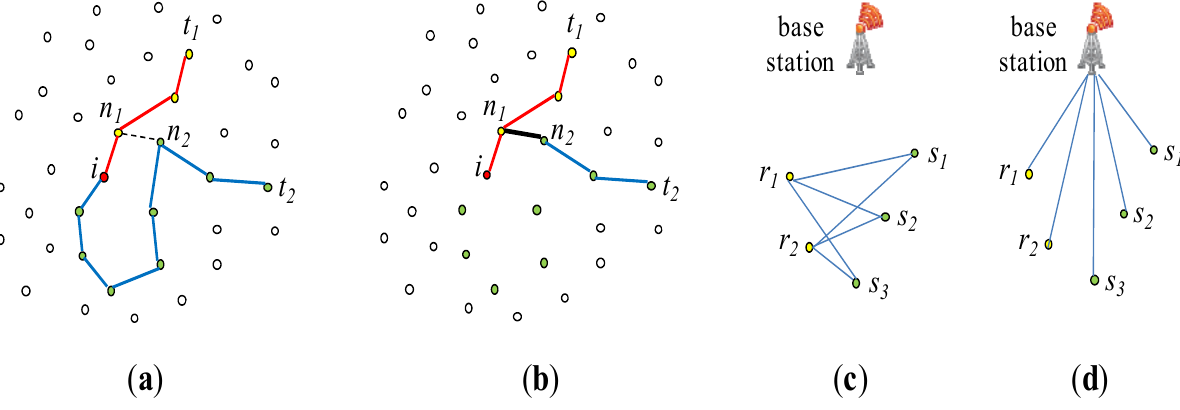
Figure 7. Multiple join pair optimization. (a) Before path collapse: there are two pair-wise joins ( i , t ) and ( i , t ). The two join paths are node-disjoint except i . There is a link between 1 2 and n ; (b) After path collapse: the link between n n 1 2 of ( i , t ) shorter; (c) Before group-based optimization for R ⋈ S , where (cid:1337) = { r 2 and (cid:2426) = { s , s , s }; (d) After group-based optimization: R ⋈ S is executed as an external 1 2 3